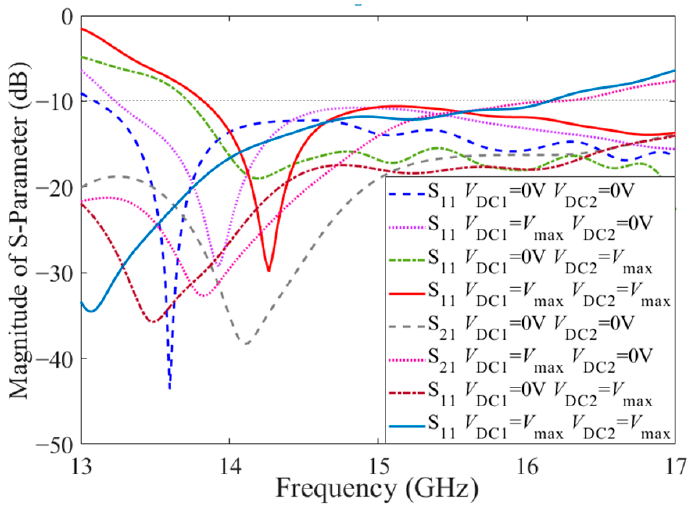
Figure 8. Magnitude of S 11 and S 21 of the electrical beam-steering CRLH metamaterial antenna under dual-tuned mode of LC. Table 3. Comparison with other LC Table 2. Comparison for the zero frequency between the unit cell and the antenna.